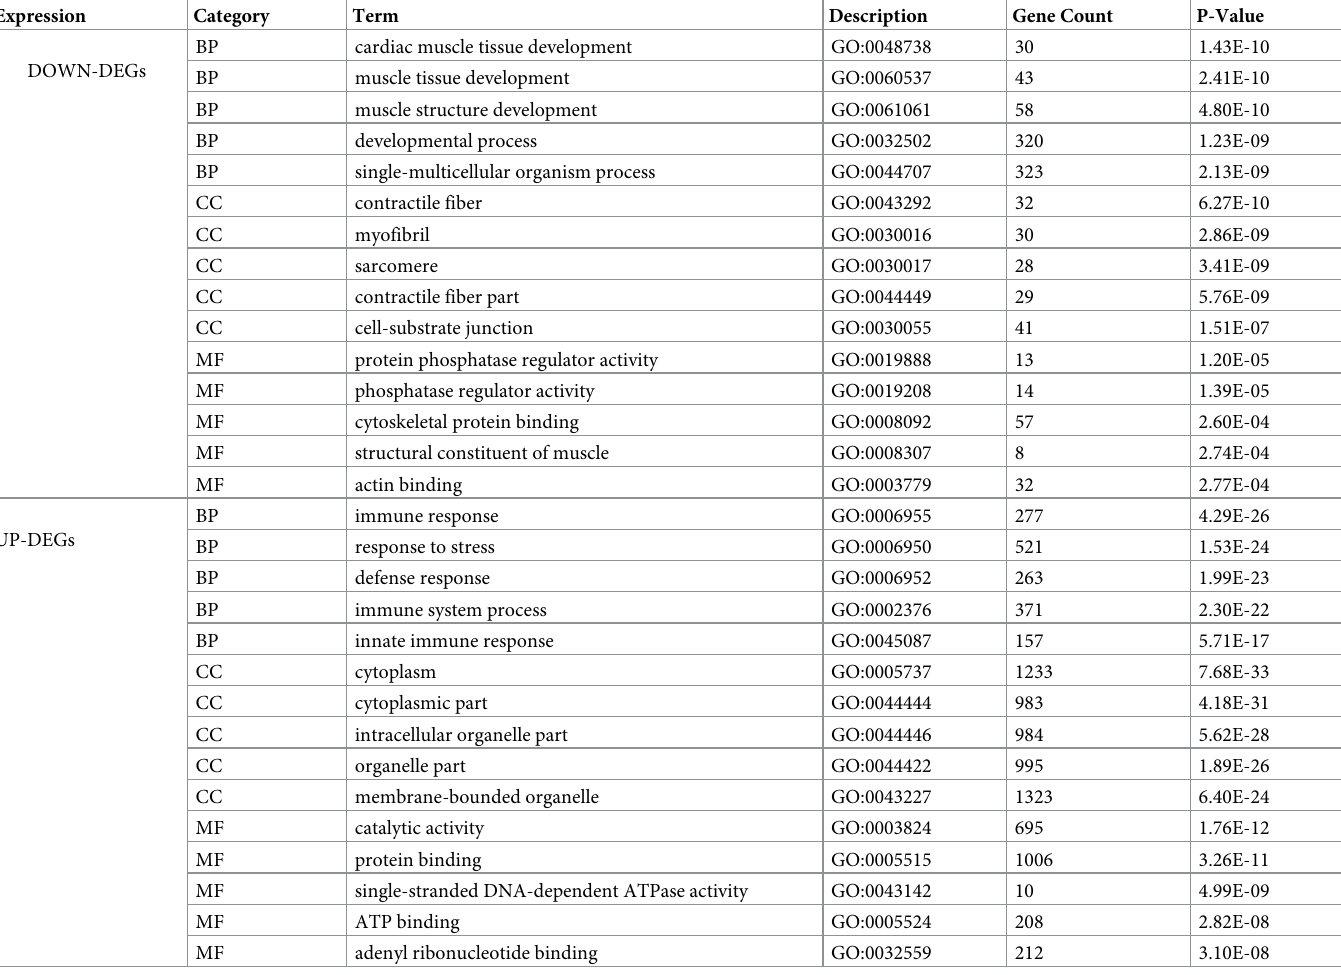
Table 2. The significantly enriched analysis of differentially expressed genes in thoracic aortic dissection. Expression